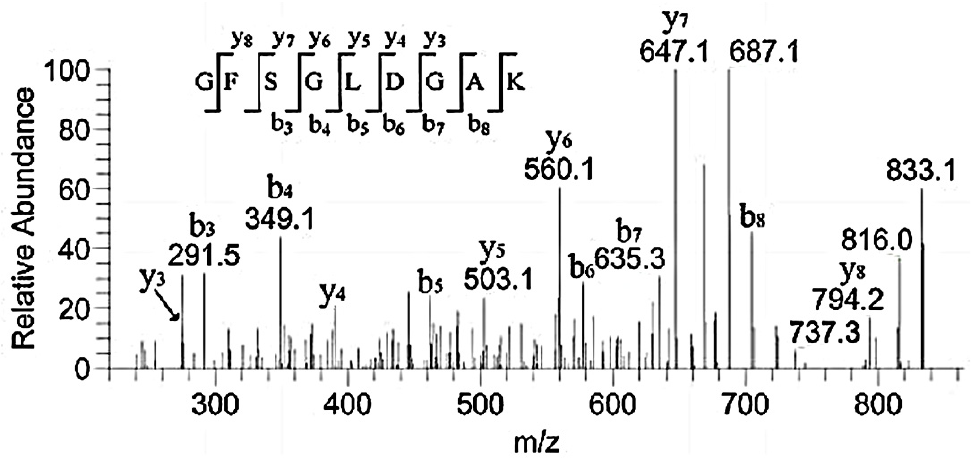
Figure 8. MS/MS spectrum of m / z 851.4 corresponding to the sequence GFSGLDGAK.